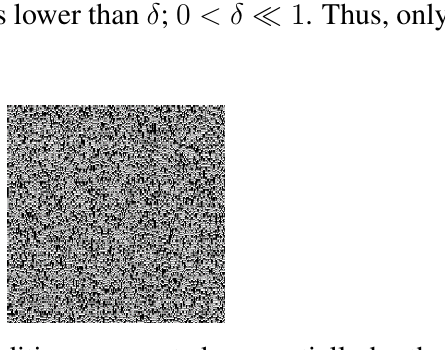
Figure 4. Pseudorandom initial conditions generated sequentially by the Logistic map; the initial value of the Logistic map a is set to 0.02. 0